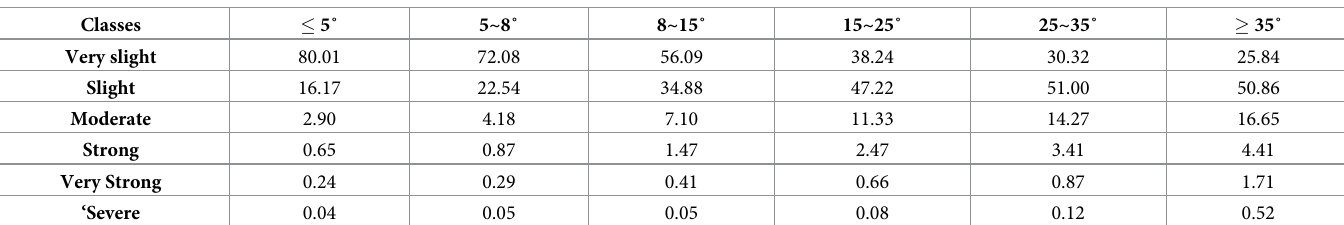
Table 7. Areas of varying intensities of soil erosion based on slope (%).